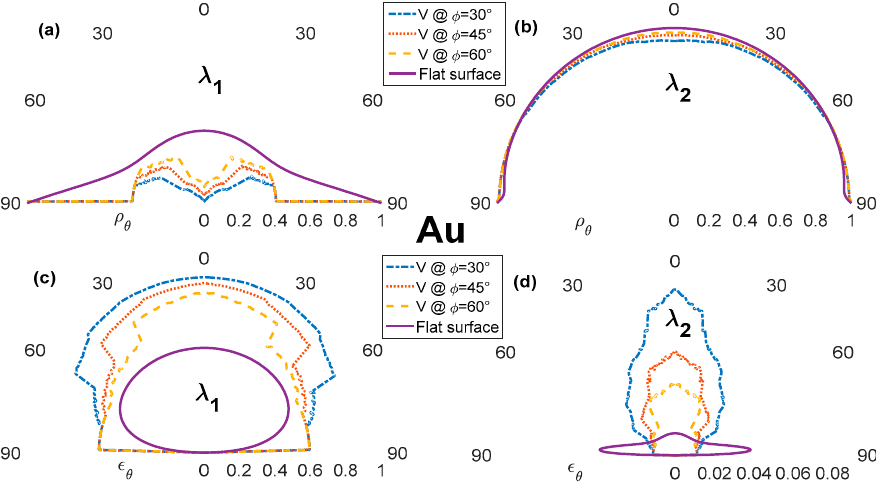
Figure 13. Spectral reflectivity of V-cavity at different aperture angles ( 𝜙 = 30°, 45°, 60°,80°,100° ) and flat surface, formed for the two chosen materials (Au and Si) in the normal direction ( 𝜃 = 0° ).